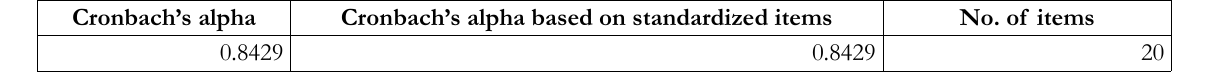
Table 1. Cronbach’s